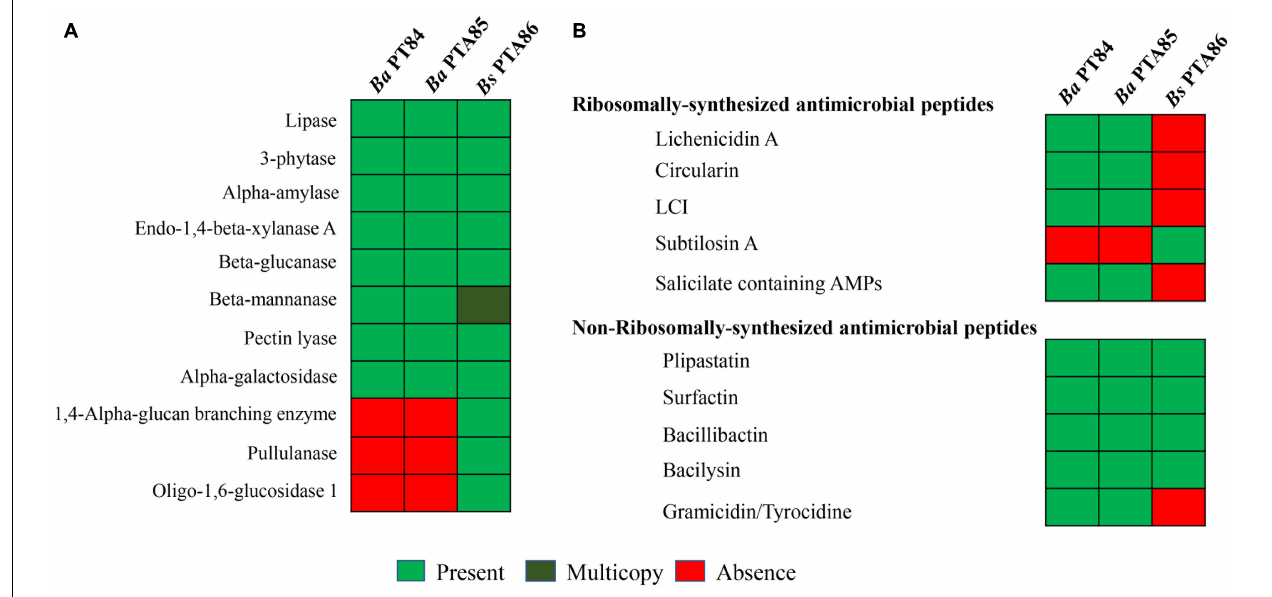
FIGURE 5 | In silico analysis of genes encoding enzymes and antimicrobial peptides in Bacillus spp. genomes. Genes encoding enzyme (A) and antimicrobial peptides (B) were compared among the genomes of three Bacillus spp., Ba PTA84 and PTA85, and Bs